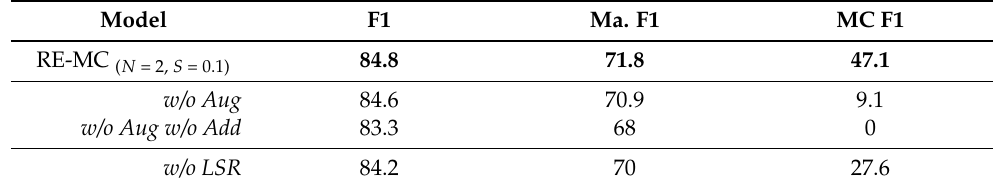
Table 7. Performance comparison for ablation study. w/o Aug denotes the removal of augmentation; w/o Add denotes the removal of additional training; and w/o LSR denotes removal of LSR when additional